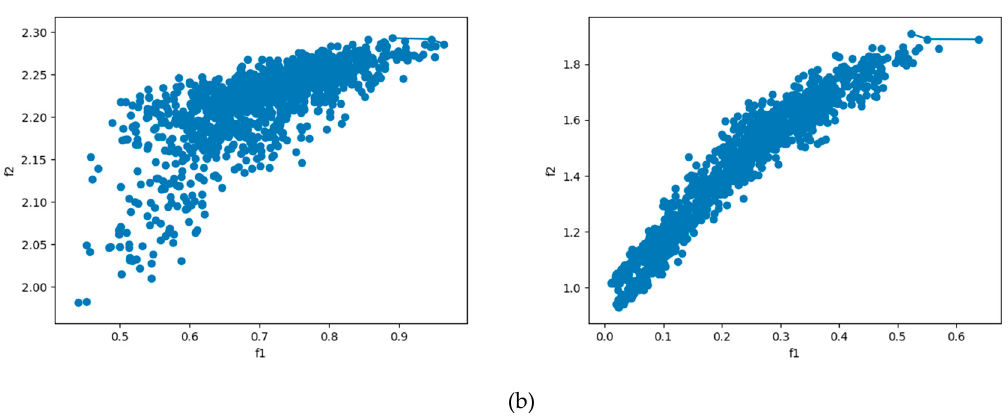
Figure 6. Pareto set selection from the target domain: ( a ) Merced → AID, and ( b ) AID-NWPU. The unknown accuracy is always 0 for all the scenarios without domain adaptation due to the negative transfer problem. The F-measure value for the AID → Merced scenario shows a degrade when no domain adaptation is applied with a minimum percentage of 34.97% from all other approaches.